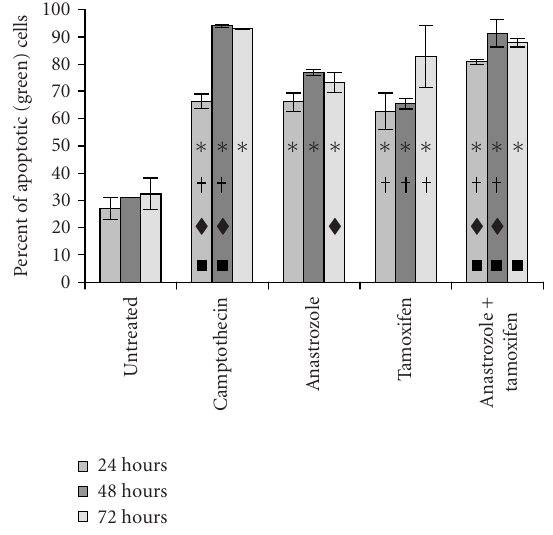
Figure 6. Light microscopy images of 4T1 cells (a) untreated or treated for 24 hours with (b) anastrozole (50 µ g/mL), (c) ta- moxifen citrate (5 µ g/mL), or (d) the combination of the two drugs. Untreated 4T1 cells are either rounded or flattened. Drug- treated cells appear mostly rounded in shape, clumped, and dis- rupted ( × 100).